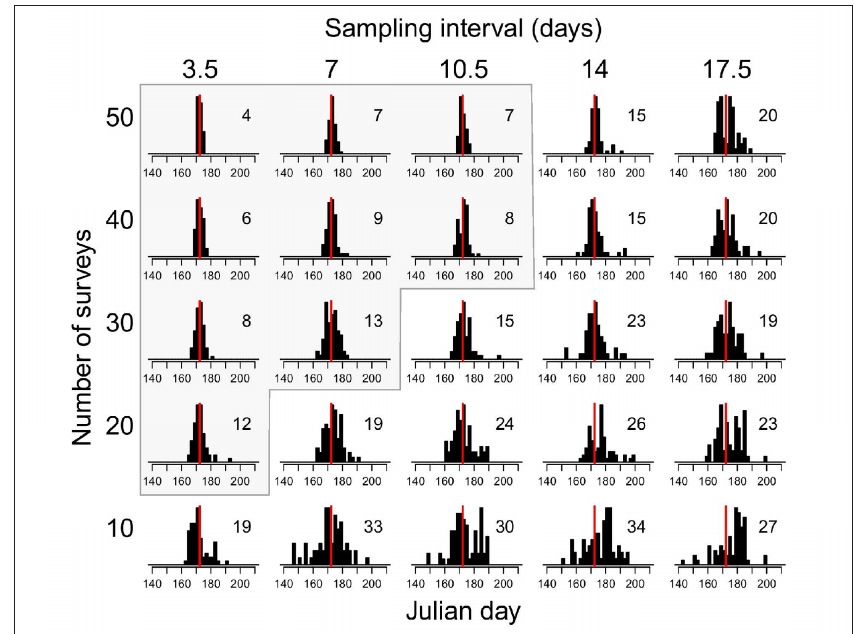
Figure 6: Estimates of peak caterpillar date based on subsampling the trained scientist beat sheet dataset of 2015 to different levels of sampling intensity (rows) and sampling frequency (columns). The “true” estimated peak date based on conducting 60 surveys twice a week was Julian day 172 (June 21; red line). Each histogram indicates the range of peak date estimates based on 60 replicate subsamples for the specified level of sampling frequency and intensity, with the 95% confidence interval width in days in the upper right corner. Sampling combinations in the gray box have confidence intervals of 13 days or